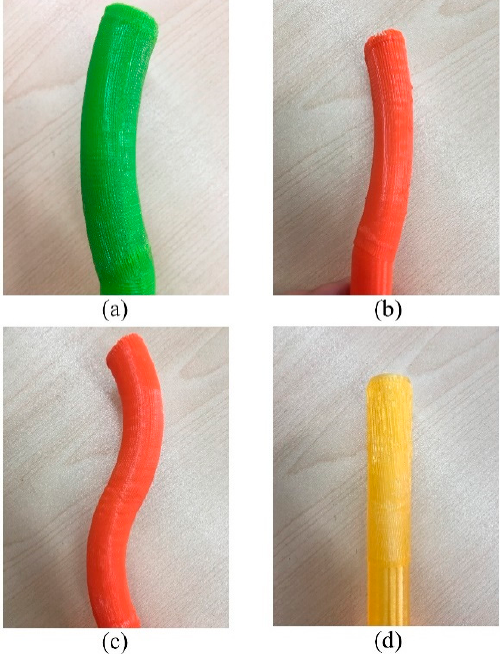
Figure 16. Typical print sample: ( a ) Circular section and plane single segment curve, ( b ) Elliptic section and plane single segment curve, ( c ) Circular section and plane multi-segment curve, ( d ) Circular section and space curve.